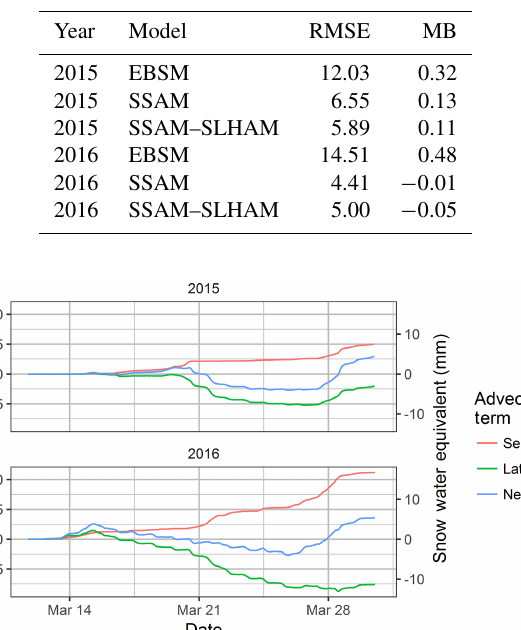
Table 5. Error metrics of snow water equivalent simulation versus snow survey observations for EBSM, SSAM and SSAM–SLHAM models.